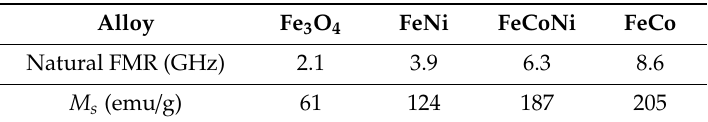
Figure 13. FMR (ferromagnetic resonance) intensity response at 4 kOe influenced by MNPs/NCS weight ratio (LR = loading rate in wt.%), for magnetite (Fe 3 O 4 ) MNPs deposited onto GO supports. Table 3. Dependence of FMR on M s for various alloys. M s values were determined by SQUID